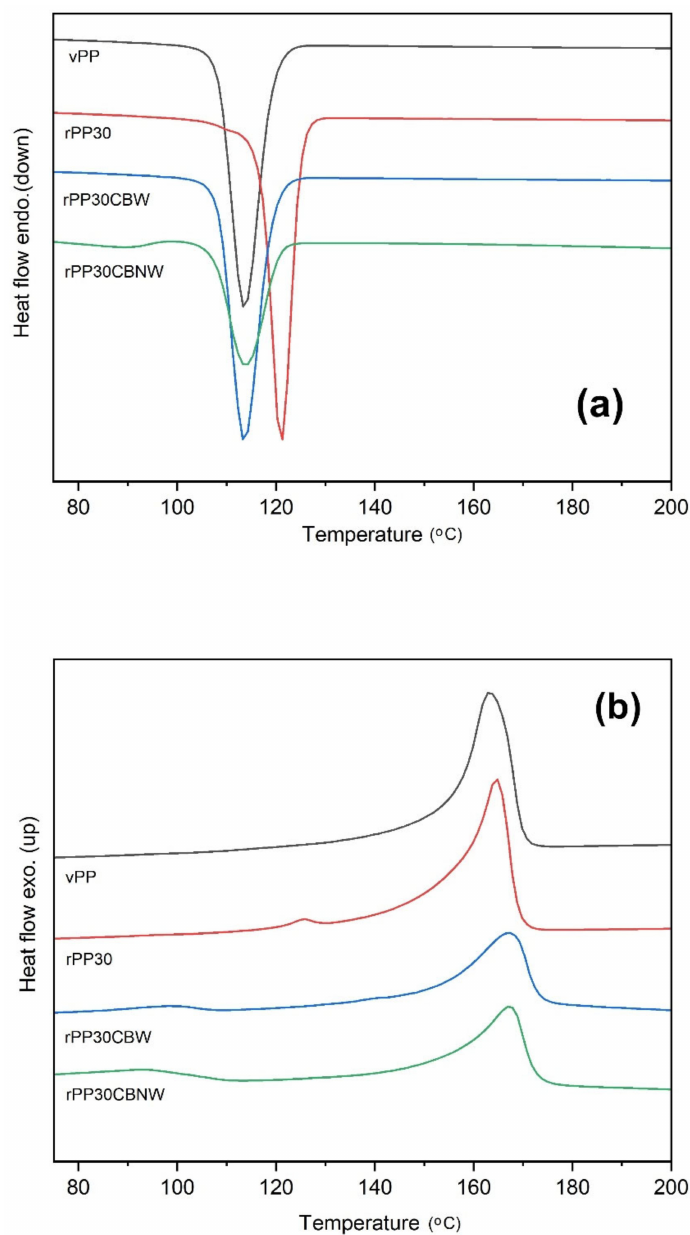
Figure 11. Crystallization temperature ( a ) and melting temperature ( b ) of vPP, rPP30, and its